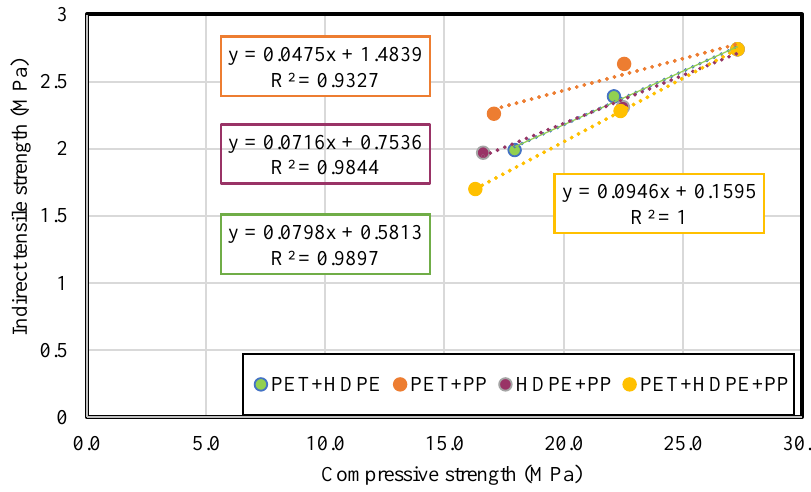
Figure 8. The relationship between the compressive and indirect tensile strengths.